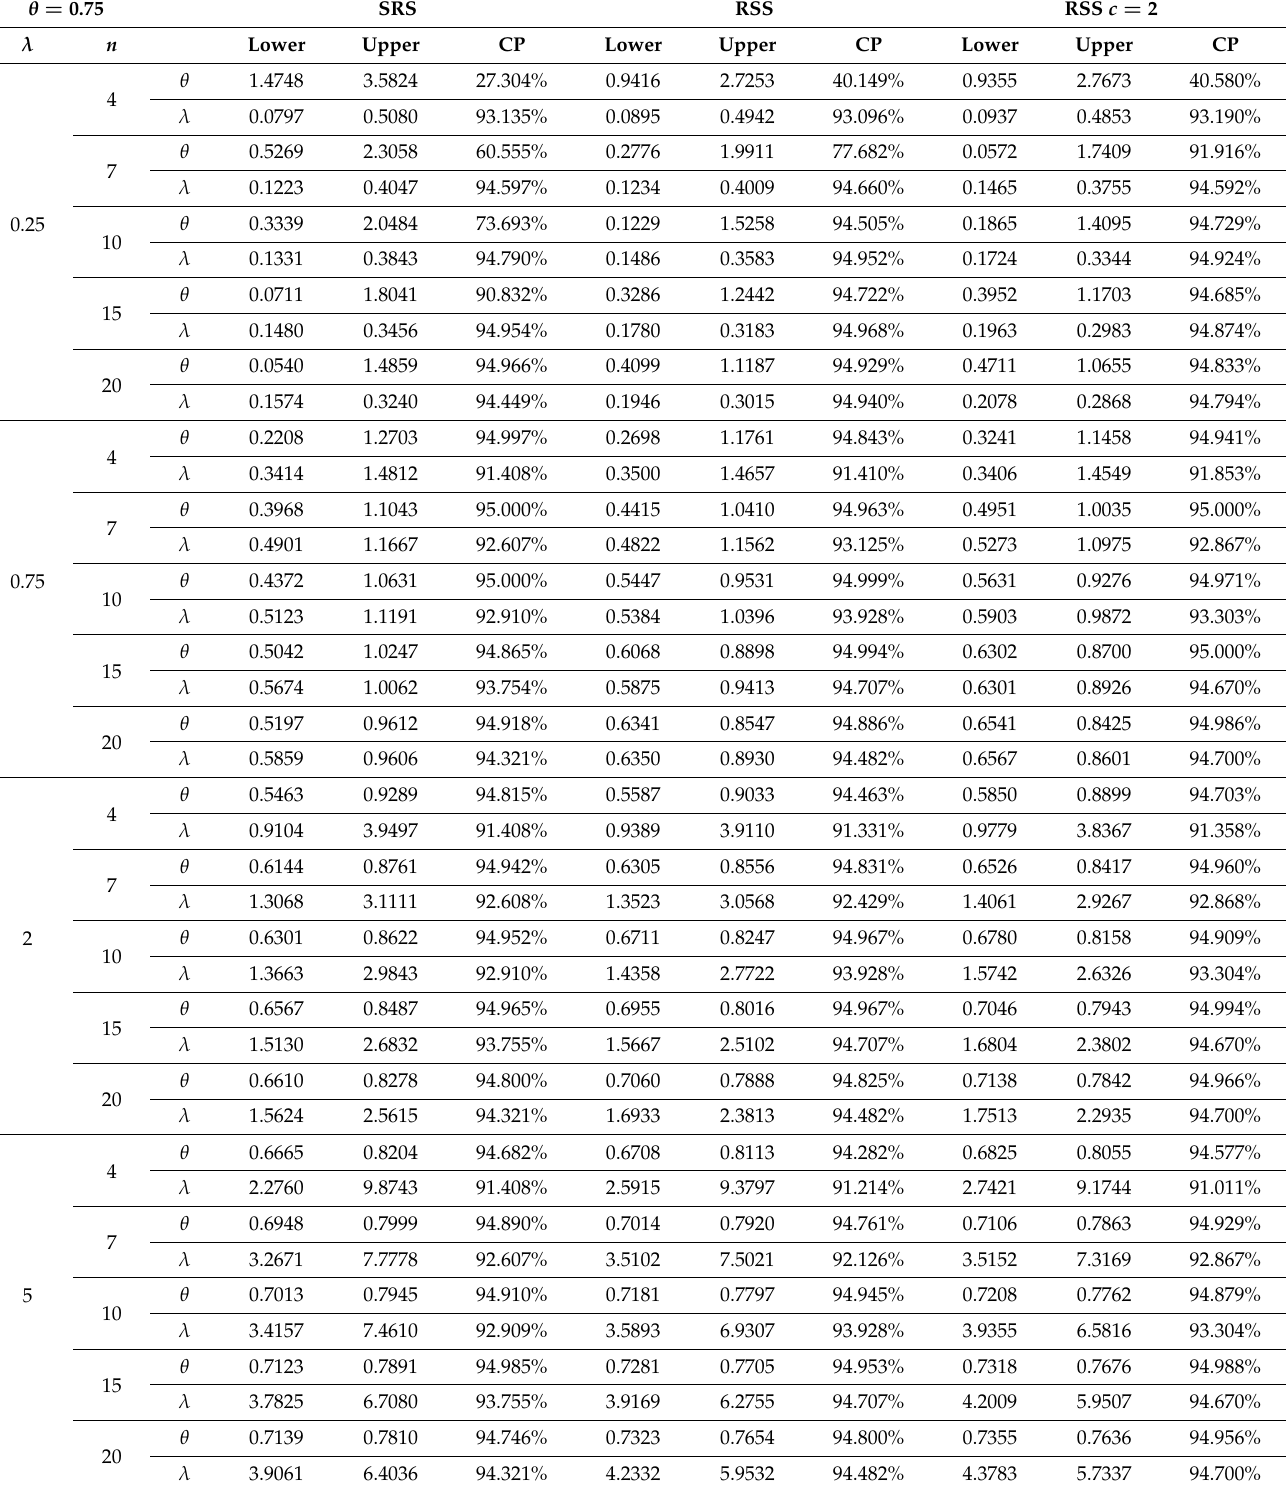
Table 7. Lower, upper bounds of CI and CP for the GB( θ , λ ) distribution under the SRS and RSS schemes when θ =